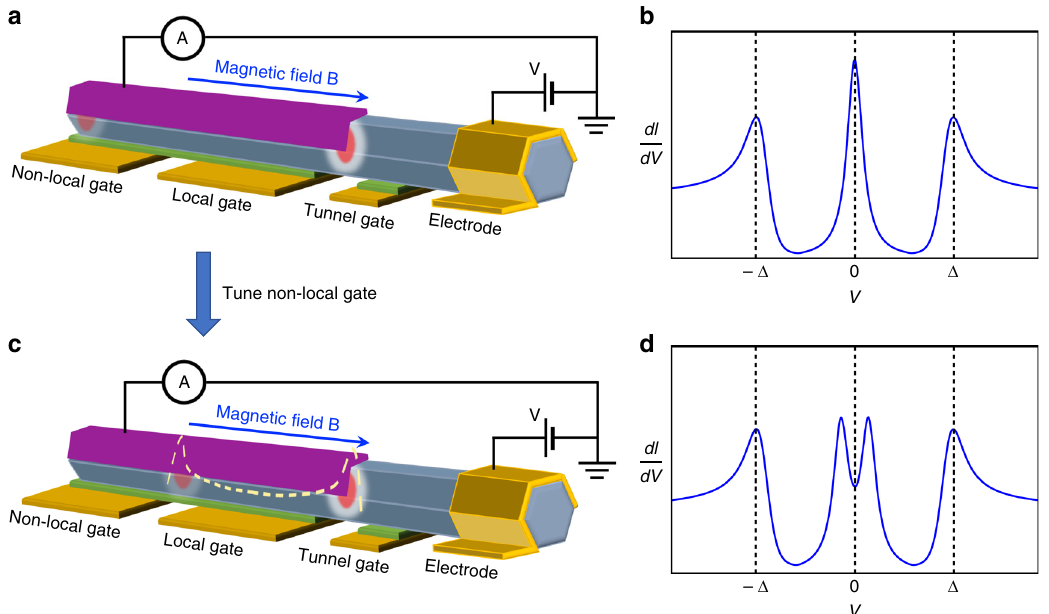
Fig. 2 Majorana device for non-local gate control. a , c Schematic experimental setup with two separated gates tuning the electro-chemical potential. By fi xing the local-gate and tuning the non-local gate, the left (remote) MZM moves to the right and hybridizes with the right (local) MZM. Therefore, the d I /d V , which detects the local density of state (LDOS) near the tunnel barrier, shows a peak ( b ) to split-peak ( d ) transition. Δ indicates the superconducting